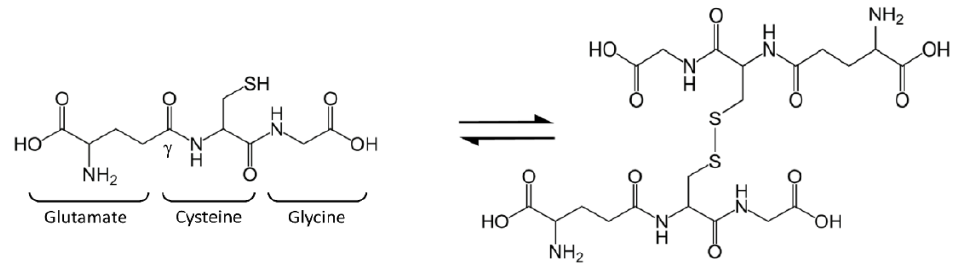
Figure 1. Glutathione (GSH) structure and balance between GSH and glutathione disulfide (GSSG).